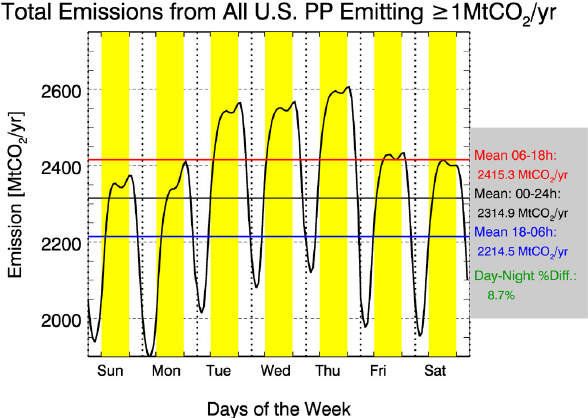
Fig. 2. Diurnal cycle of CO 2 emissions summed over all power plants (PP) in the US emitting more that 1.0MtCO 2 yr − 1 for 2008. The hours between 06:00a.m. to 06:00p.m. (daytime) are high- lighted in